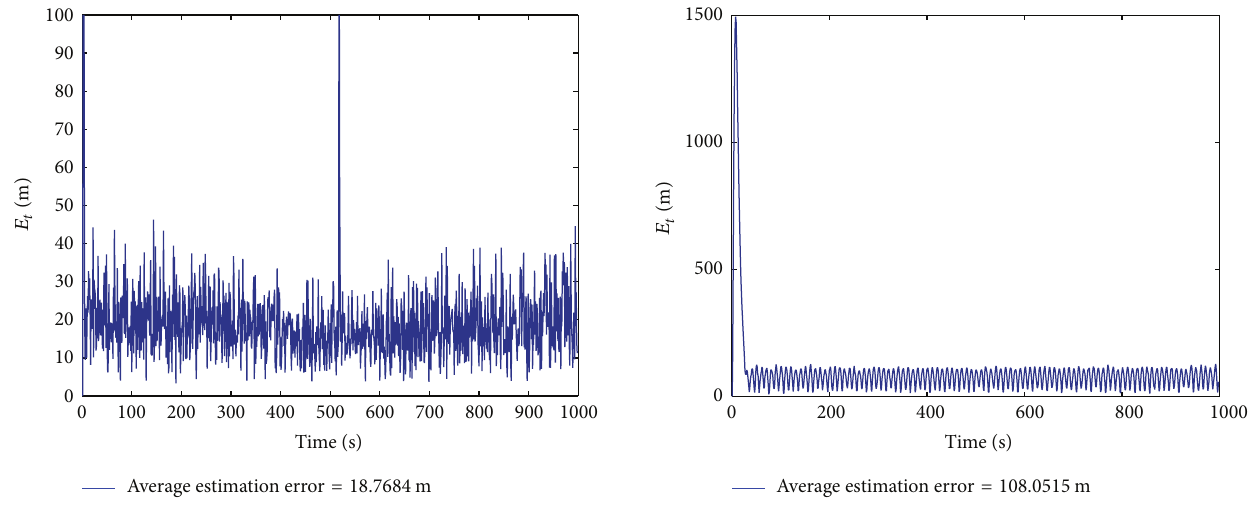
Figure 20: Estimation error of PSO based adaptive 𝛼 - 𝛽 - 𝛾 filter.